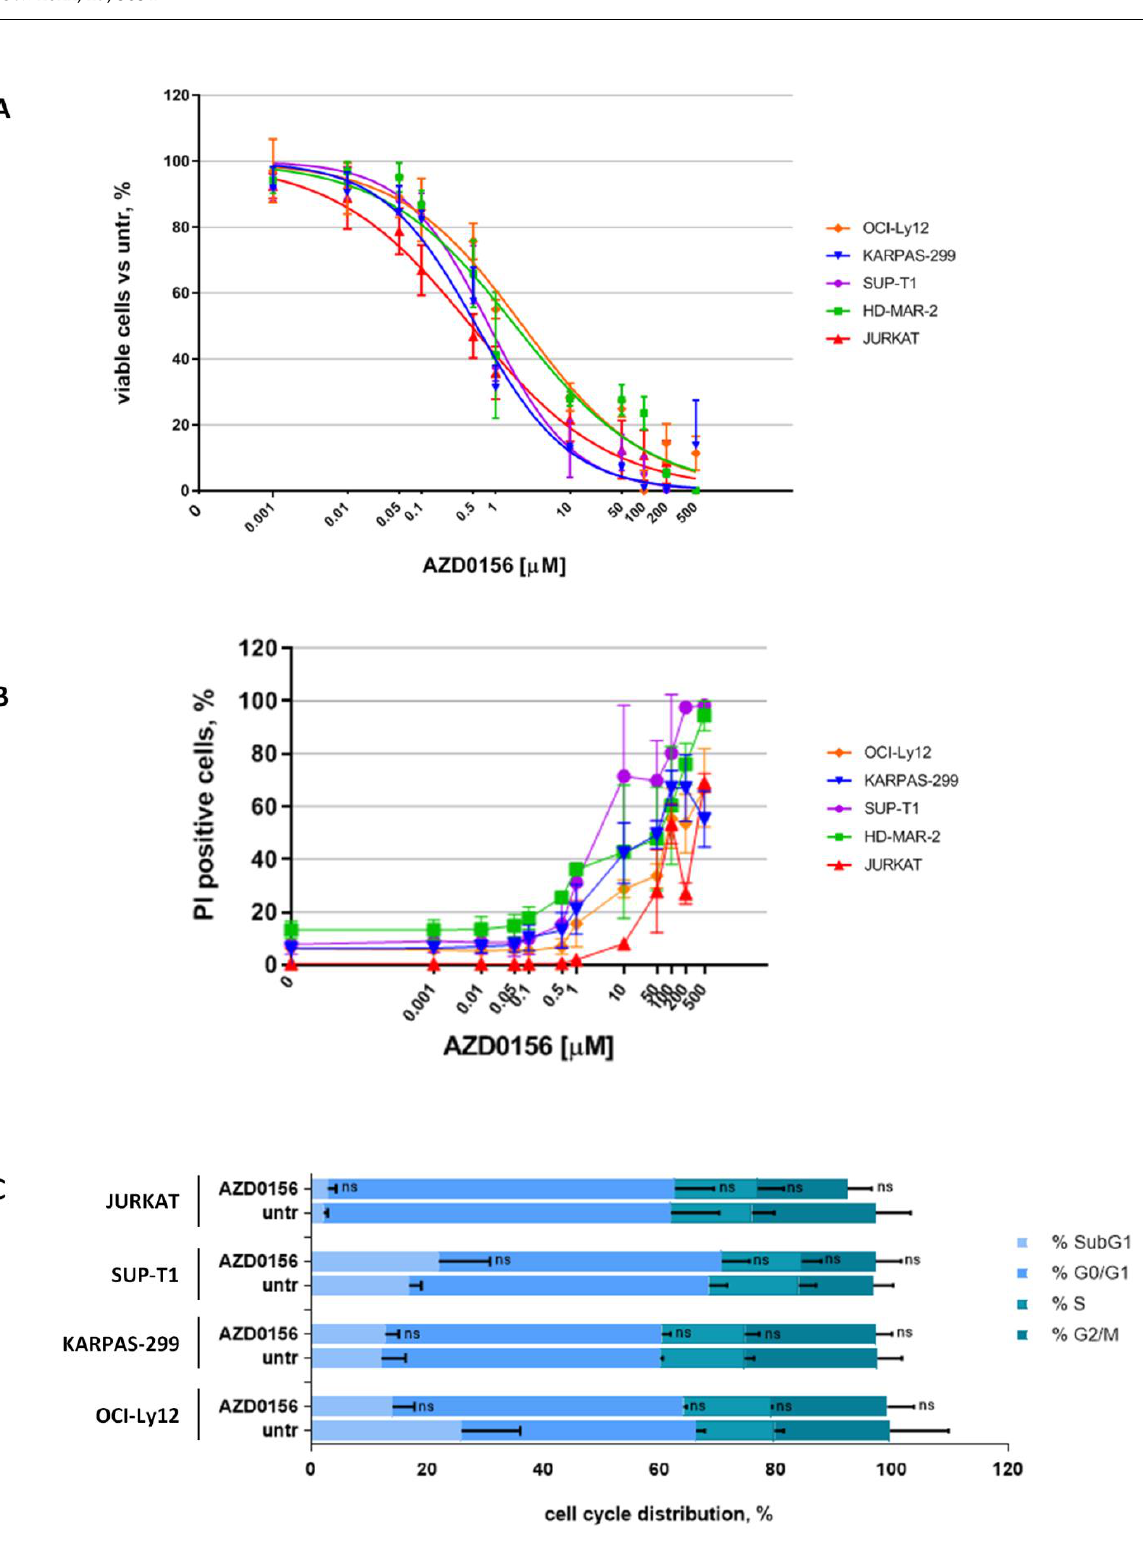
Figure 2. ATM inhibitor AZD0156 has a cytotoxic effect on malignant T cells. Cell lines were exposed to increasing concentrations of AZD0156 (range 1 nM–500 µ M) for 48 h. Then cells were studied by flow cytometry. Titration curves are reported ( A ), dead cells (PI-positive) ( B ), and cell cycle distribution ( C ) were monitored. In ( A , B ), data are expressed as percentage of untreated samples and are the mean ± SD of at least four independent experiments. In ( C ), data are the mean ± SD of at least two independent experiments (ns: not significant).